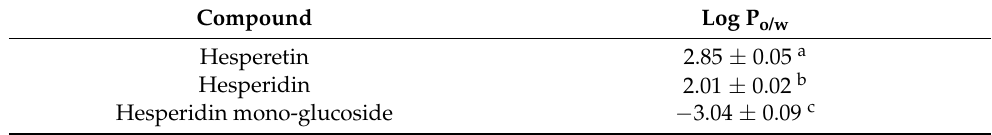
Table 1. n-Octanol/water partition coefficients of hesperetin, hesperidin and hesperidin